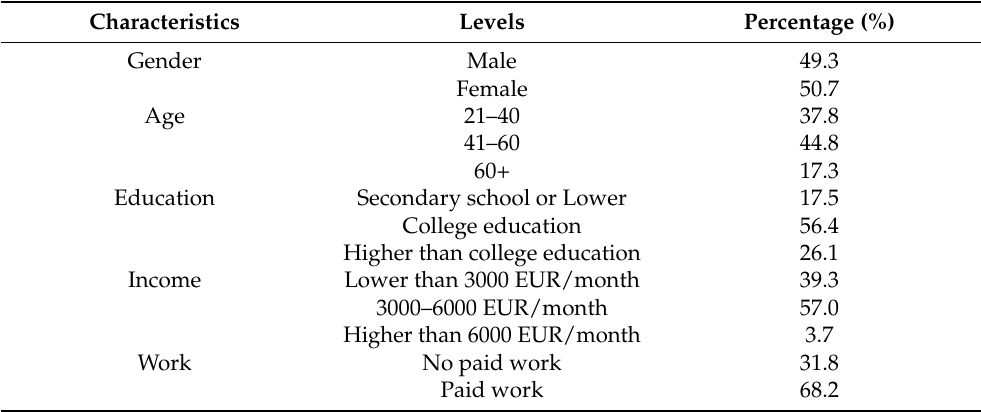
Table 3. Distribution of sample socio-demographic